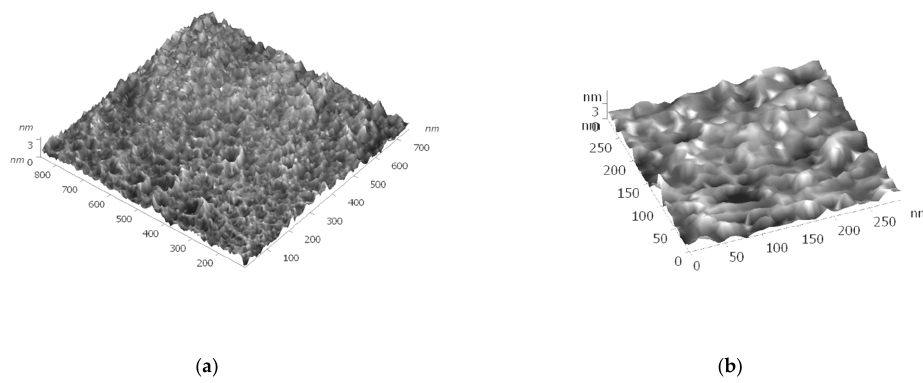
Figure 4. ( a ) The AFM 3D image of nanoparticles based on Fe III x (acac) y 18C6 m (H 2 O) n ; ( b ) the AFM 3D image of nanoparticles based on triple system Fe III x (acac) y (His) m (Tyr) n (H 2 O) p .